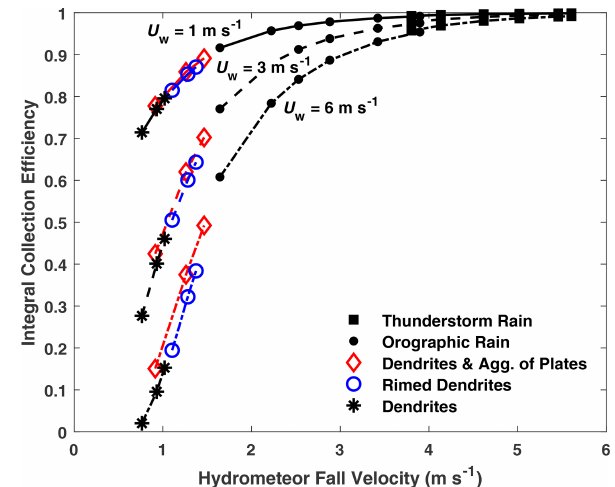
Figure 5. Integral Geonor unshielded gauge collection efficiency with hydrometeor fall velocity at median volume diameter for rain- fall and snowfall types at 1, 3, and 6ms − 1 wind